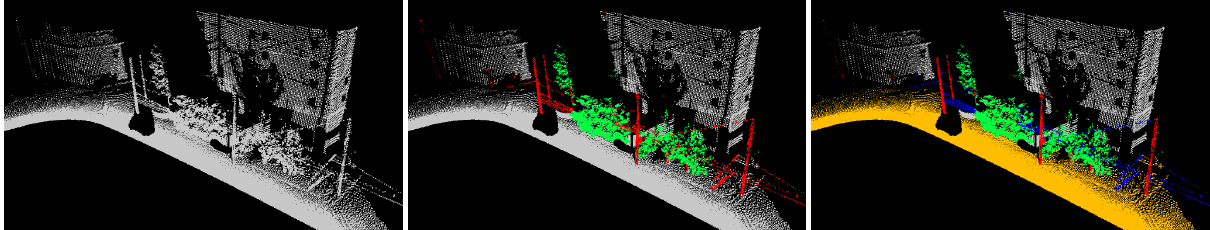
Figure 1. Visualization of a point cloud (left) and two reference labelings: the labeling in the center refers to three structural classes that are represented by linear structures (red), planar structures (gray) and volumetric structures (green); the labeling on the right refers to five semantic classes that are represented by Wire (blue), Pole / Trunk (red), Fac¸ade (gray), Ground (orange) and Vegetation